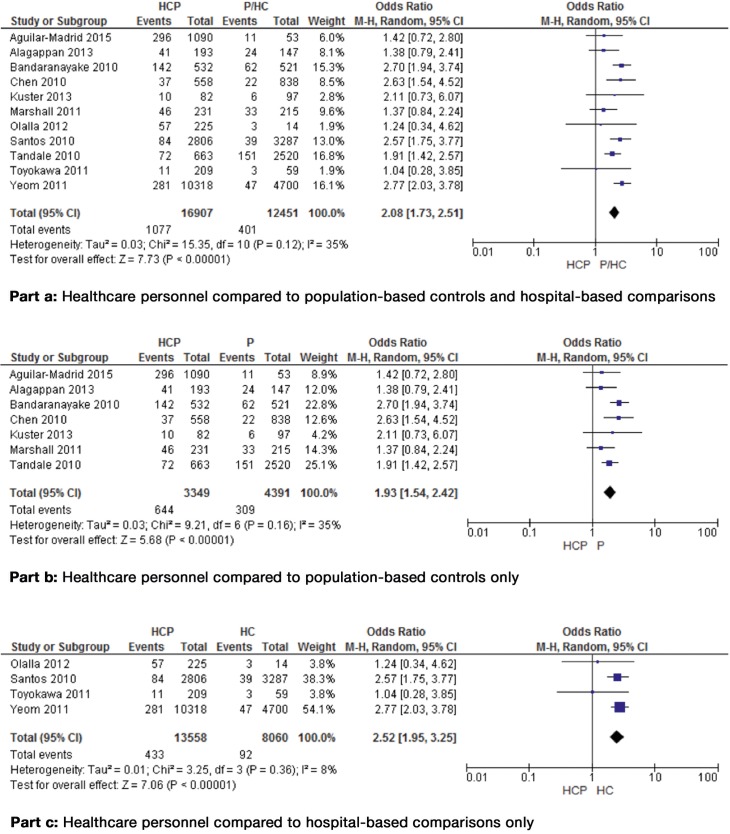
Forest plots showing the risk of influenza A (H1N1) infection for HCP compared to population-based controls/hospital-based comparisons (part a) and controls/comparisons only (part b and c). Abbreviations: CI: confidence interval, df: degrees of freedom, HC: hospital-based comparisons, HCP: healthcare personnel, M-H: Mantel-Haenszel, P: population-based controls.